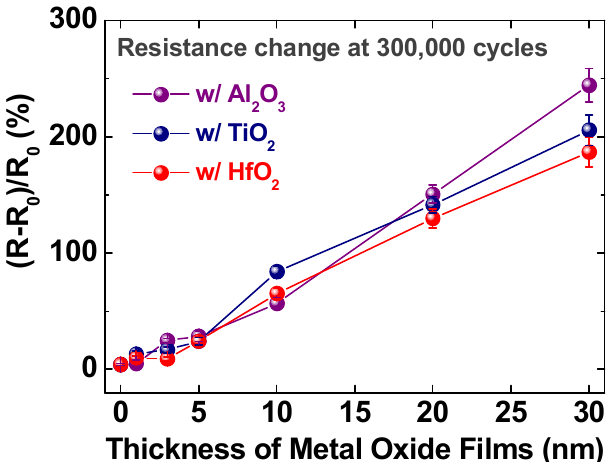
Figure 18. Resistance change of the silver nanowire network with Al 2 O 3 , TiO 2 , and HfO 2 overcoating with different thicknesses. Reproduced with permission from ref. [52]. Copyright 2019, Elsevier.